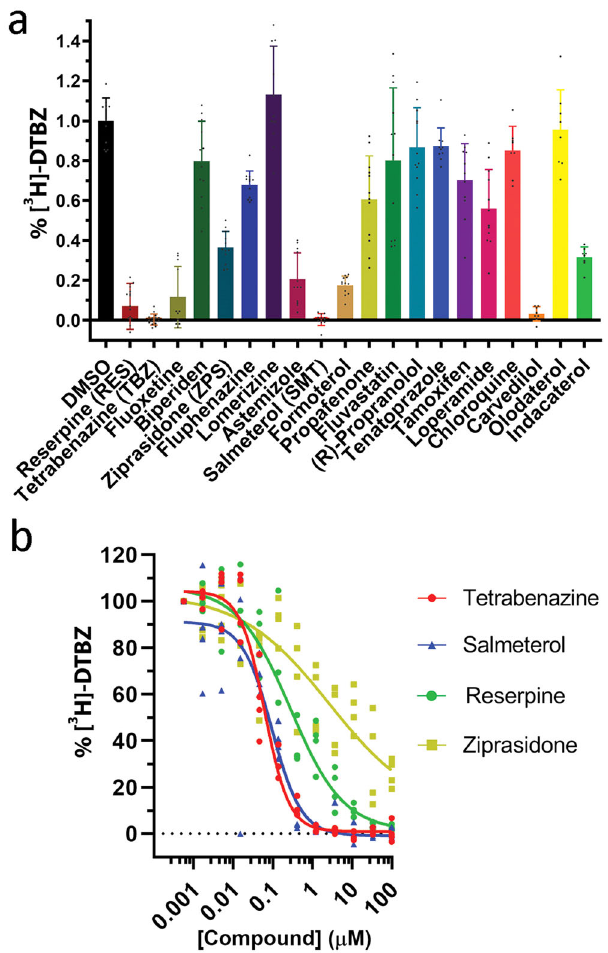
Fig. 3 Competition of [ 3 H]-DTBZ binding assay. a Cells were preincubated with 50 μ M of compounds in 96 well plates and [ 3 H]-DTBZ (5 nM) binding was measured. Bars represent mean ± SD, from 3 independent experiments with 3 or 4 repetitions for DMSO controls and each compound. Reserpine (RES), tetrabenazine (TBZ), fl uoxetine, ziprasidone (ZPS), fl uphenazine, astemizole, salmeterol (SMT), formoterol, propafenone, tamoxifen, loperamide, carvedilol and indacaterol had a statistically signi fi cantly effect on [ 3 H]-DTBZ binding (compared with DMSO control; one-way ANOVA, p < 0.001). Biperiden, lomerizine, fl uvastatin, propranolol, tenatoprazole, PCIPYR-0044, chloroquine and oldaterol had no statistically signi fi cant effect on [ 3 H]-DTBZ binding. b EC 50 determination for competition of [ 3 H]-DTBZ binding by tetrabenazine (TBZ, red), salmeterol (SMT, blue), reserpine (RSP, green) and ziprasidone (ZPS,